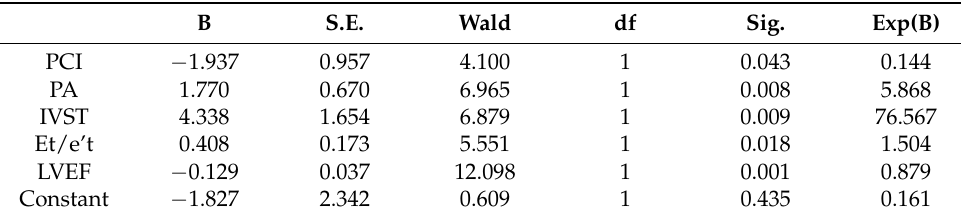
Table 4. Association of variables before surgery with MACE 18 months after CABG (binary logistic regression analysis, forward likelihood ratio).